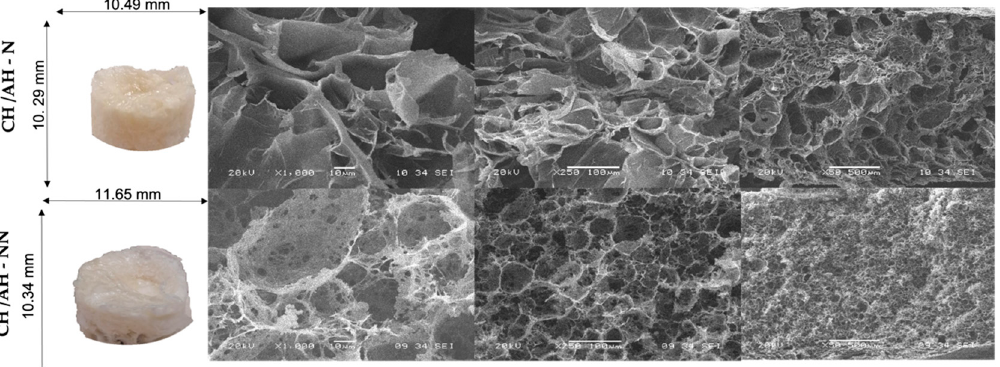
Figure 1. SEM surface morphology of neutralized (CHT/AH–N) and non-neutralized (CHT/AH– NN) CHT–AH scaffolds.